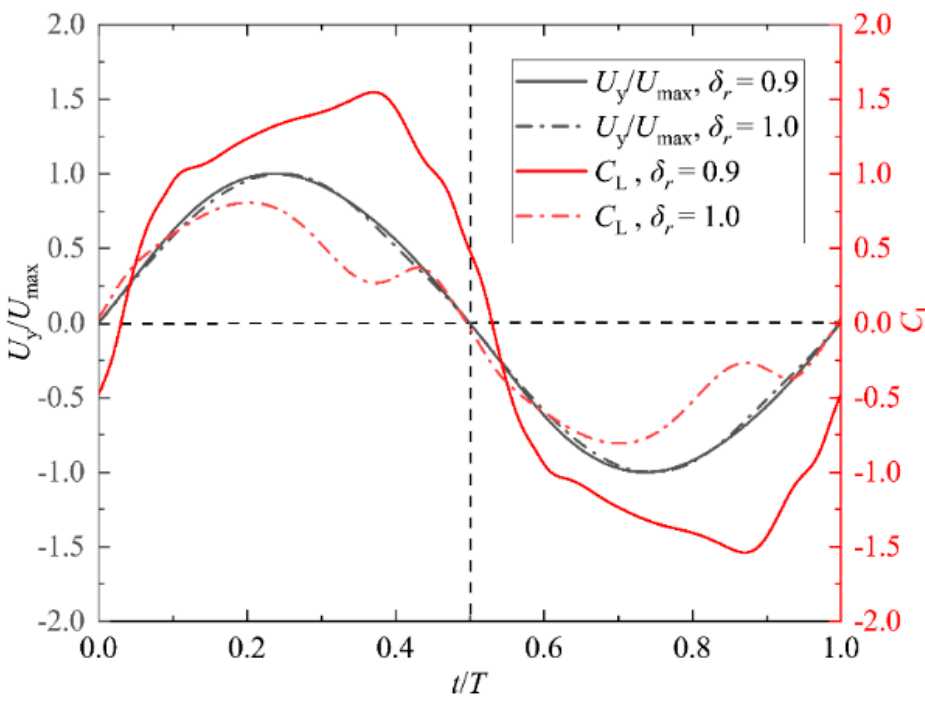
Figure 16. Historical lift coefficient and plunging velocity at different mass-damping parameters. Mass-damping parameters of 0.9 and 1.0 are selected for detailed flow insight due to the sudden reduced plunging amplitude. Figure 17 depicts the evolution of the vorticity field in half-cycle (upstroke) for the cases of large and small plunging amplitudes. In the case of a large plunging amplitude, the upper-edge vortex (leading-edge vortex) is attached to the suction side during most of the stroke, and the low-pressure region formed by the upper-edge vortex brings a relatively larger lift force, which is generally accepted as being responsible for the large time-averaged lift force of low Reynolds number flapping flight [32,33]. At the end of the upper stroke ( t / T = 0.5), the upper edge vortex sheds off, and the lower edge vortex forms. When the mass-damping parameter is set to 1.0, the upper edge vortex sheds off near t / T = 0.4, causing the departure of the corresponding low-pressure region from the plate surface and thus the lift valley near t / T = 0.4 as shown in the Figure 14. Between t / T = 0.4 and t / T = 0.5, a smaller upper edge vortex is produced, resulting in a small recovery of lift. In a word, when the mass-damping parameter is set at 0.9, the attachment of the upper edge vortex lasts longer, leading to a higher average lift coefficient and thus better energy harvesting